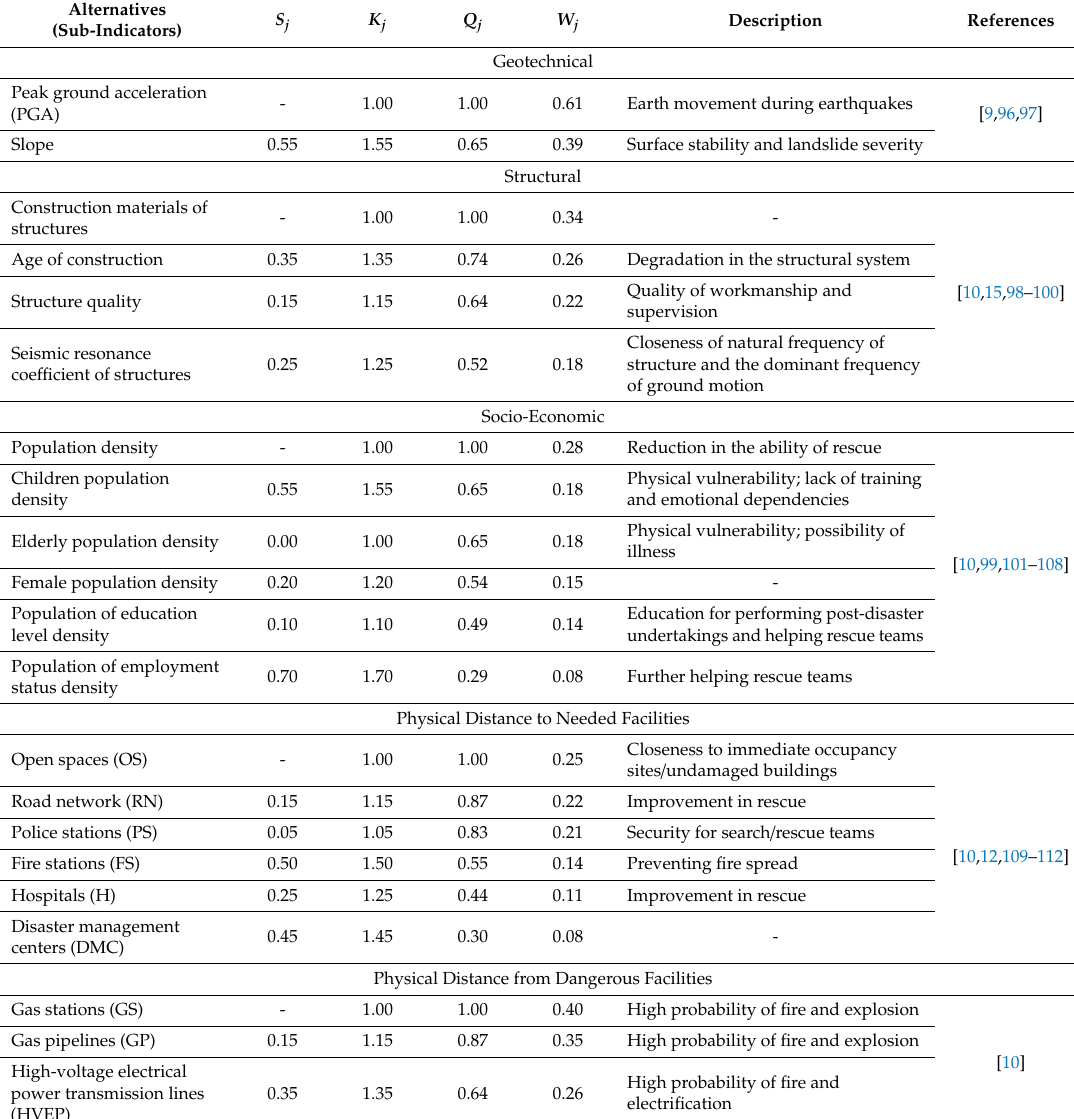
Table 2. Calculated weight of alternatives using